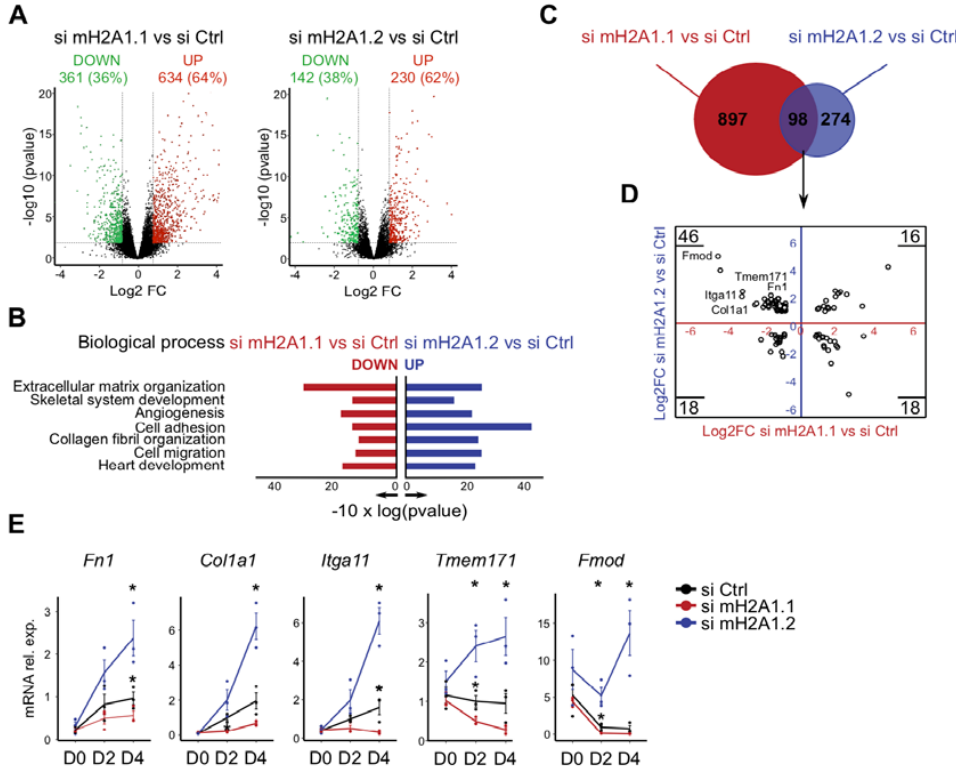
Figure 3. MacroH2A1 (mH2A1) isoforms a ff ect genes related to extracellular matrix and adhesion in an opposing manner. ( A ) Volcano plot of -log10 of the adjusted p -value versus the log2 fold-change (FC). Dashed lines demarcate the chosen cutoffs of <0,01 and 0.8 for p-value and log2FC, respectively. Significant deregulated genes are highlighted in green (down) or orange (up). The analyzed data were obtained from three independent biological replicates. ( B ) Gene ontology analysis of downregulated genes with si mH2A1.1 versus upregulated with si mH2A1.2 ( p < 0.05). The analyzed data were obtained from three independent biological replicates. ( C ) Venn diagram of deregulated genes identified in (A). ( D ) Scatterplot of deregulated genes (98) identified in (A) and shared in both comparisons, si mH2A1.1 versus control and si mH2A1.2. Five fusion genes of interest are highlighted. ( E ) Validation of selected genes by RT-qPCR during differentiation at days 0, 2 and 4 (left to right). Data is the mean of four independent experiments + SD; * p < 0.05; Student’s t -test.